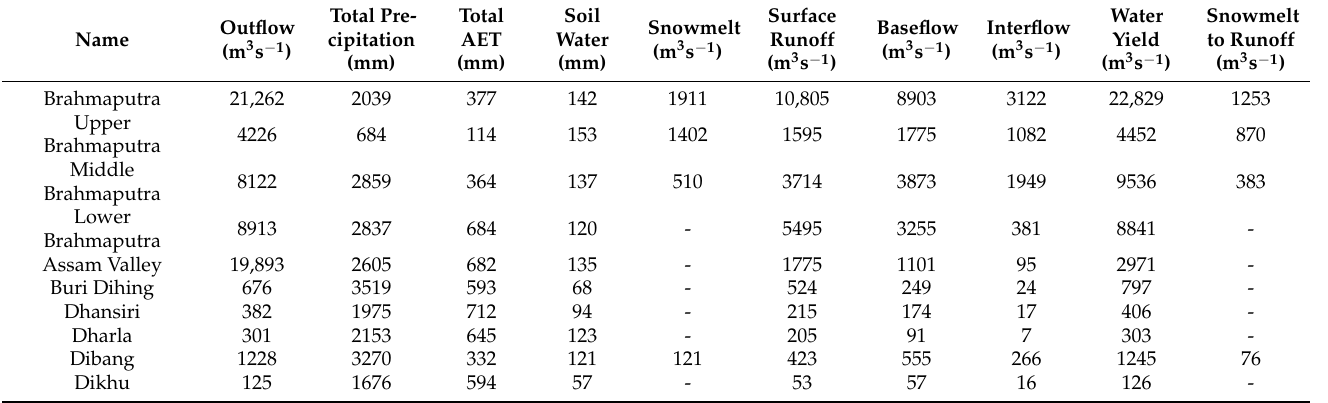
Table 6. Annual average outflow, precipitation, evapotranspiration, snowmelt, baseflow, and water yield in the base period